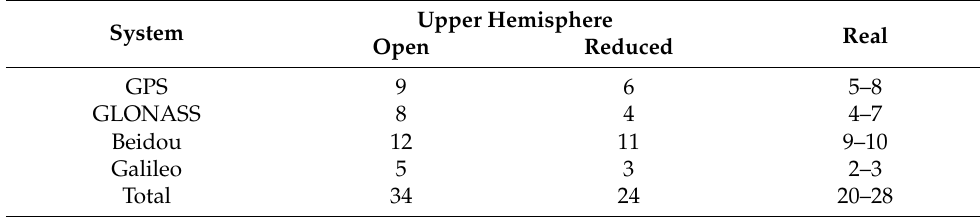
Figure 10. Individual ( a , b , d , f ) and cumulated ( c , e , g ) number of visible satellites. Table 5 shows the number of satellites available in the surveyed water region during the performance of surveys, the number reduced by cutting off part of the upper hemisphere with harbour buildings, and the number recorded using a Topcon HiPer VR receiver during last survey (four systems). Table 5. Number of available satellites.